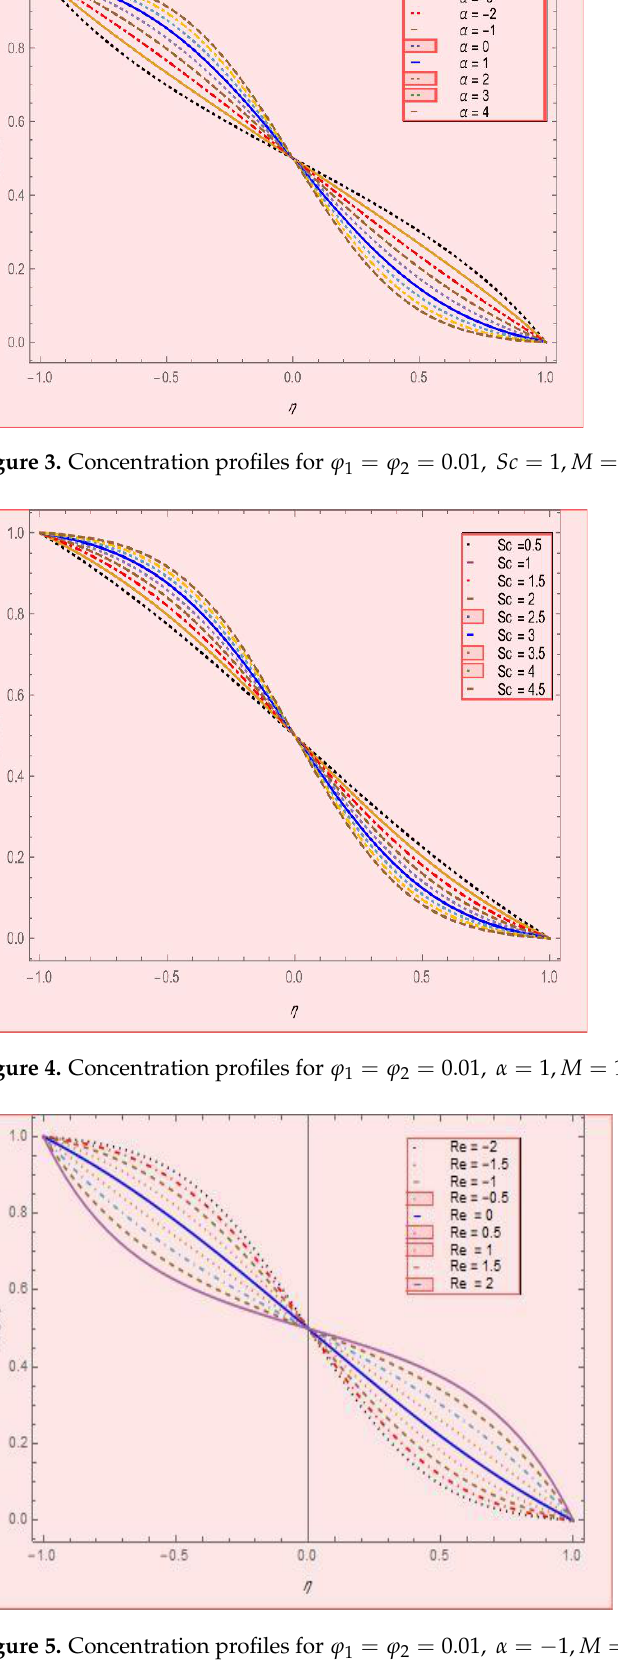
Figure 5. Concentration profiles for 𝜑 1 = 𝜑 2 = 0.01, 𝛼 = −1, 𝑀 = 1, 𝑆𝑐 = 1, 𝑃𝑟 = 6.2.